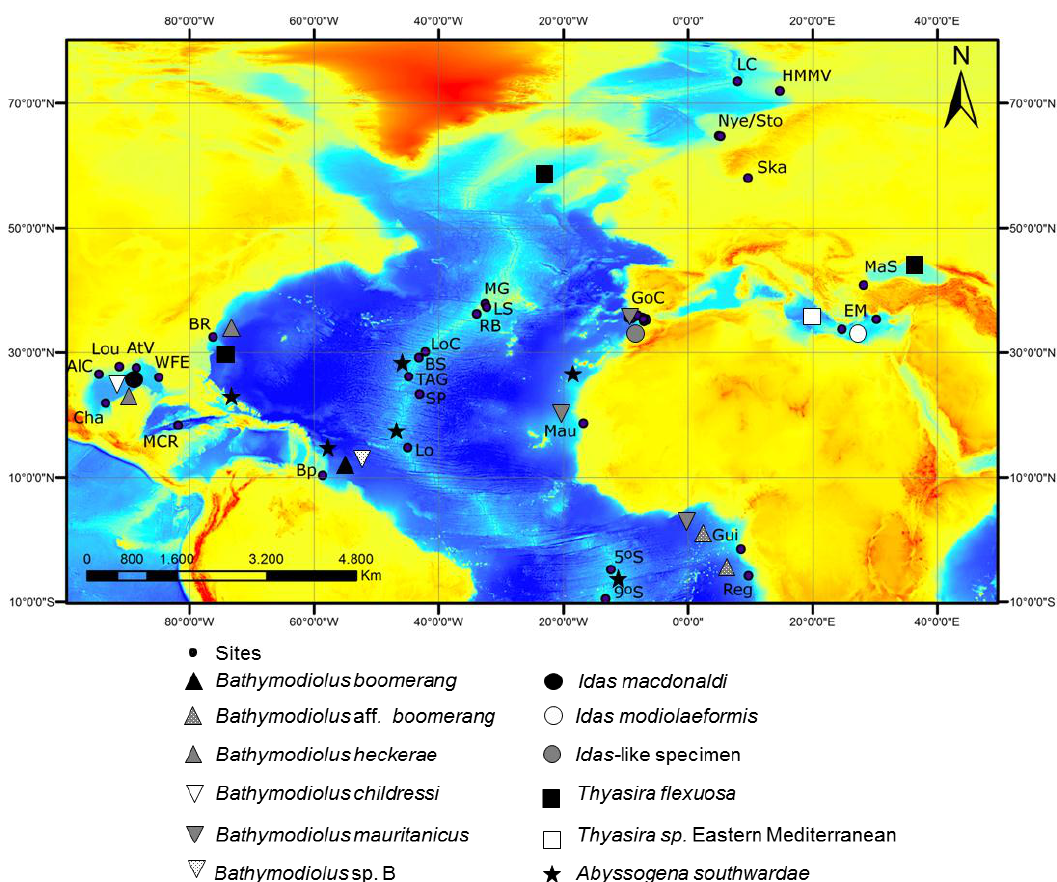
Fig. 1. Map displaying the deep-sea hydrothermal vent and cold seep sites from which chemosymbiotic bivalves were sampled in the North Atlantic and Mediterranean. Western Atlantic (including Gulf of Mexico) from north to south: Blake Ridge (BR), Louisiana slope (Lou), Atwater Valley (AtV), Alaminos Canyon (AlC), West Florida Escarpment (WFE), Chapopote (Cha), Mid-Cayman Ridge (MCR), Barbados prism (Bp); Mid-Atlantic Ridge (MAR) from north to south: Menez Gwen (MG), Lucky Strike (LS), Rainbow (RB), Lost City (LoC), Broken Spur (BS), Trans-Atlantic Geotraverse (TAG), Snake Pit (SP), Logatchev (Lo), 5 ◦ S and 9 ◦ S; eastern Atlantic from north to south: Loki’s Castle (LC), Haakon Mosby (HMMV), Nyegga/Storegga (Nye/Sto), Skagerrak (Ska), Gulf of Cadiz (GoC), Mauritania basin (Mau), Guiness (Gui) and Regab (Reg) sites at Gulf of Guinea; Mediterranean Sea from west to east: eastern Mediterranean (EM) and Sea of Marmara (MaS). Bivalve species or sister species with a trans-Atlantic distribution are indicated by symbols, a similar shape (for example, circle) indicating same (identical color) or sister (distinct colors)